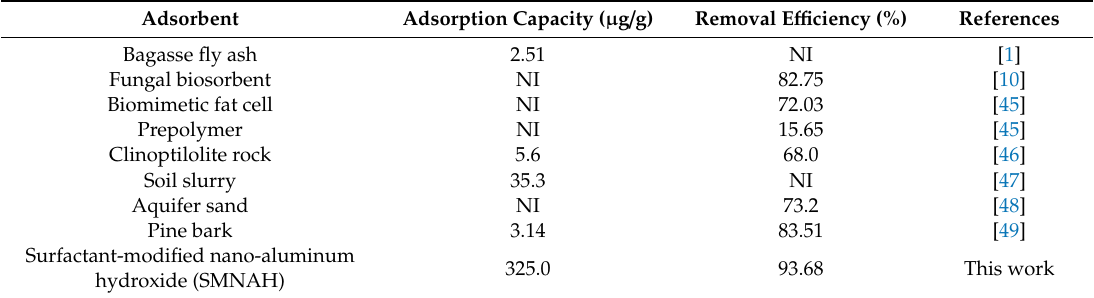
Table 3. Adsorption capacity and removal e ffi ciency of surfactant-modified nano aluminum hydroxide (SMNAH) and other absorbents for lindane removal.